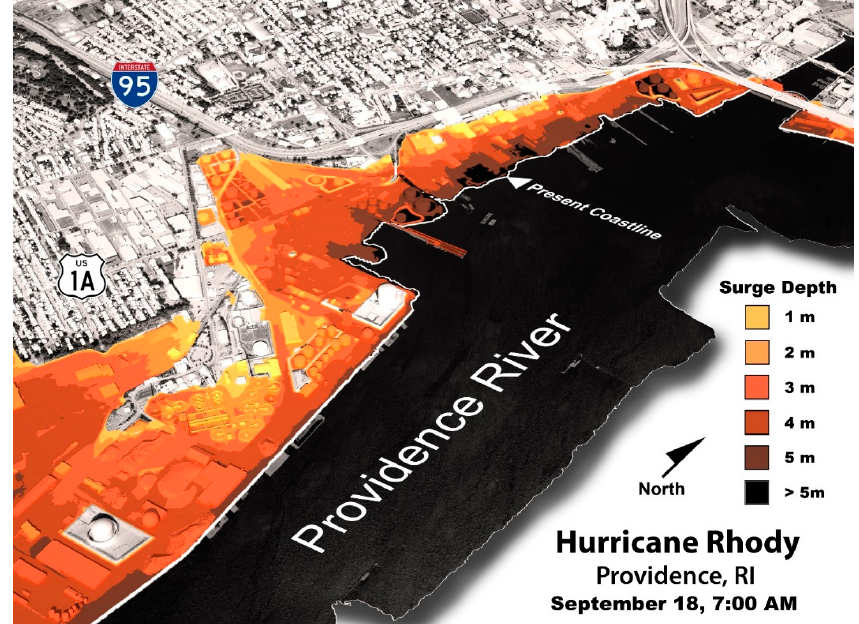
Figure 2. Visualization depicting inundation of energy infrastructure in Providence, RI, USA, used for a training exercise (FEMA IEMC) that took place in June of 2017. This training exercise used time incremented 3D models of coastal communities and infrastructure to depict the landfall of a modeled extreme storm event. Although structures were individually modeled and tested, specific representations of damage were not included to avoid creating misleading impressions. The presence of recognizable landmarks and highway interchanges orients local viewers. Image: